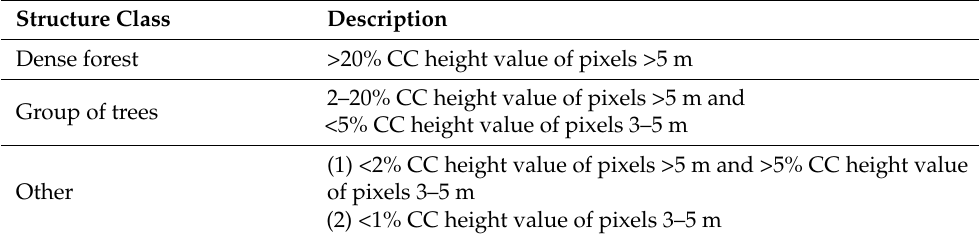
Table 1. Definitions of the three vegetation structure classes “dense forest”, “group of trees”, and “other” based on Canopy Cover (CC) percentage and height, as extracted per 50 × 50 m image patch. Structure Class